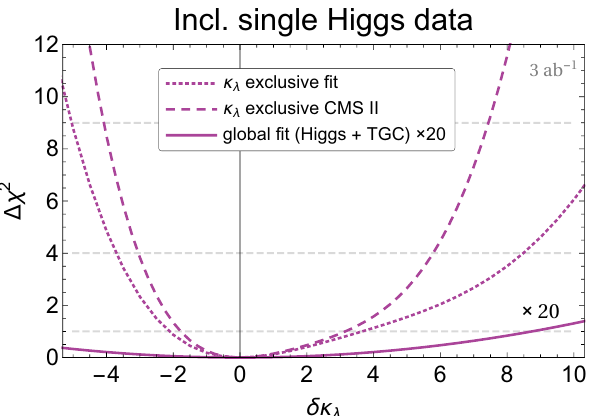
Figure 2 . (cid:31) 2 as a function of the Higgs trilinear coupling (cid:20) (cid:21) obtained by performing a global (cid:12)t including the constraints coming from TGC’s measurements and the bound on the h ! Z(cid:13) decay rate. The results are obtained by assuming an integrated luminosity of 3 = ab at 14 TeV. The dotted curve corresponds to the result obtained by setting to zero all the other the Higgs- coupling parameters, while the solid curve is obtained by pro(cid:12)ling and is multiplied by a factor 20 to improve its visibility. To compare with previous literature (ref. [6]), we also display the exclusive (cid:12)t performed assuming the uncertainty projections from the more optimistic ‘Scenario 2’ of CMS [29] (dashed